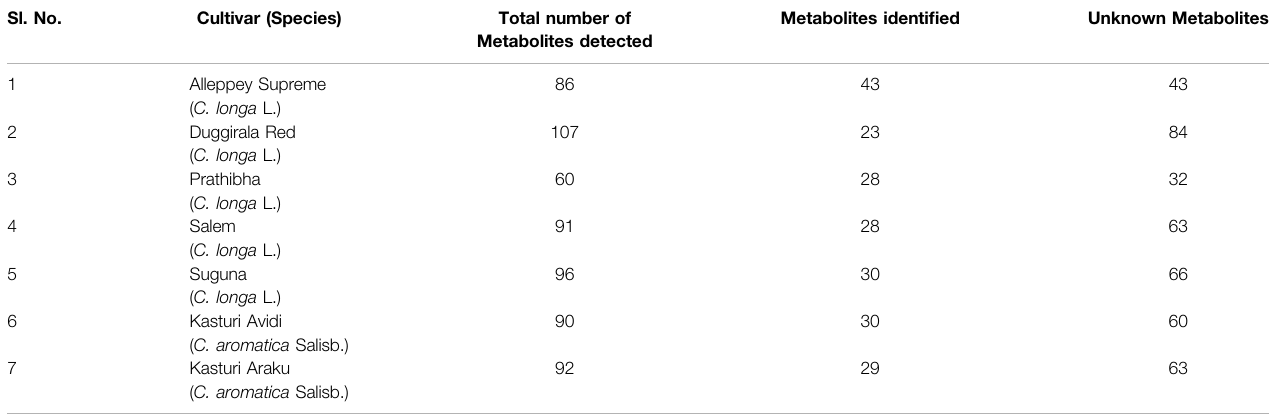
TABLE 5 | Total number of compounds detected by LC-MS from the rhizome extract of C. longa L. and C. aromatica Salisb. Sl.